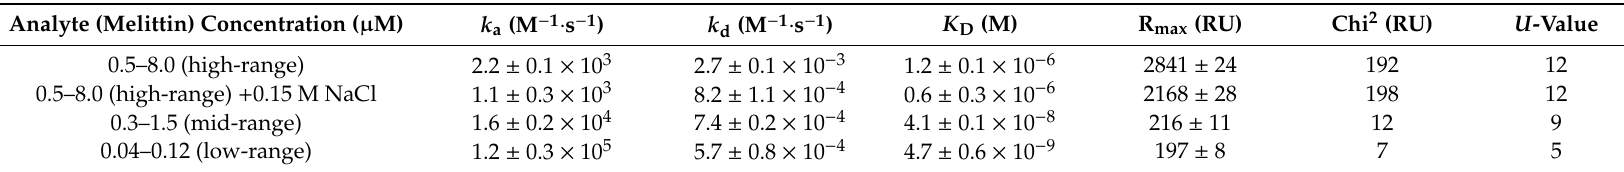
Table 1. Kinetic and data-fitting parameters for melittin–POPC interactions based on a 1:1 Langmuir model. Data were measured at the three concentration ranges and obtained from fitting sensorgrams to a 1:1 Langmuir model to obtain estimates of association ( k a ) and dissociation rates ( k d ) as well as binding constants ( K D ), R max , Chi2 and U values. Uncertainties are given as mean ± SEM obtained from the curve fitting.